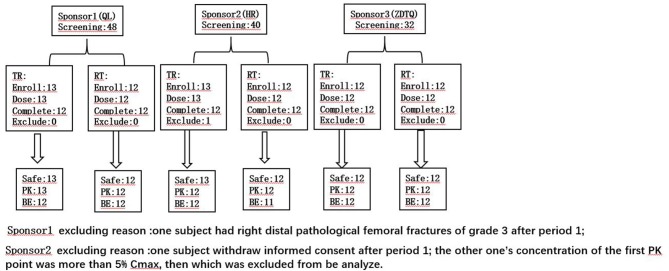
The subject number of the each analysis set. TR, D1 dosing T formulation and D22 dosing R formulation; RT, D1 dosing R formulation and D22 dosing T formulation.